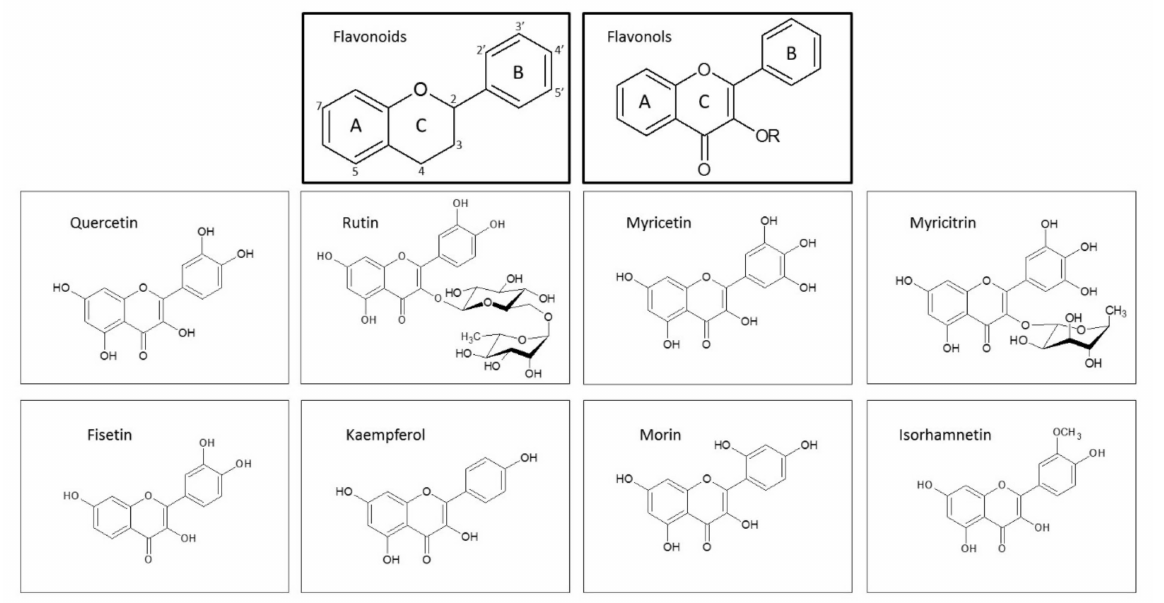
Figure 5. The basic backbone of flavonoids and flavonols, and chemical structures of main